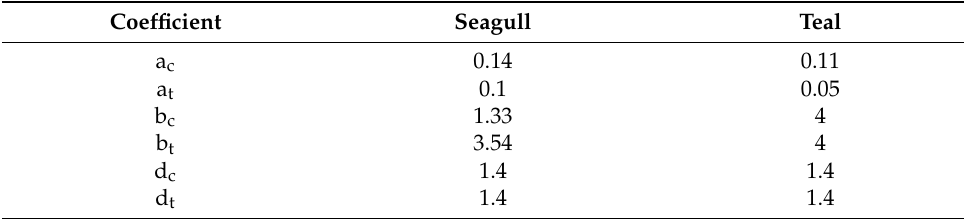
Table 2. Coefficient distribution for maximum camber and